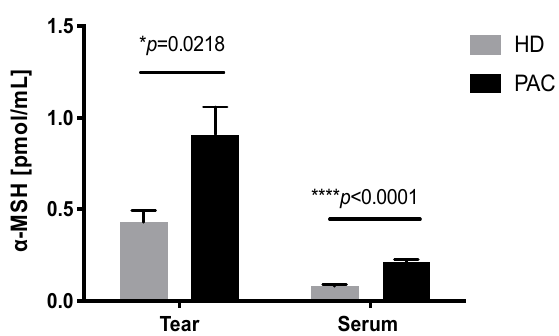
Figure 5. Concentration of α -MSH in the tears of patients with allergic conjunctivitis. α -MSH was measured through an ELISA sandwich of tear and serum samples from healthy donors (HD) and perennial allergic conjunctivitis (PAC) patients. * p ≤ 0.05; **** p ≤